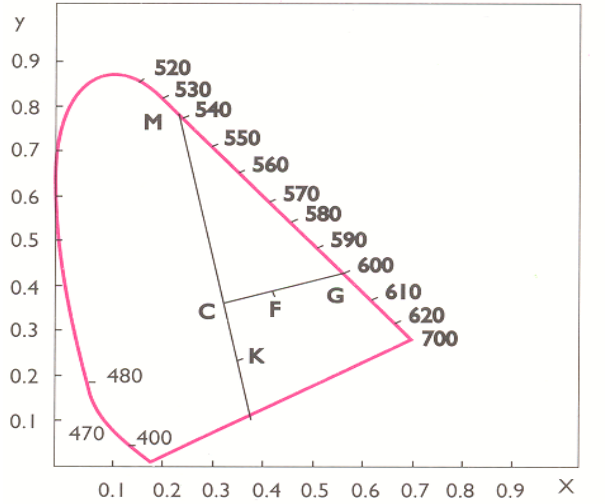
Figure 1. Determination of dominant wavelength and purity of color by CIE